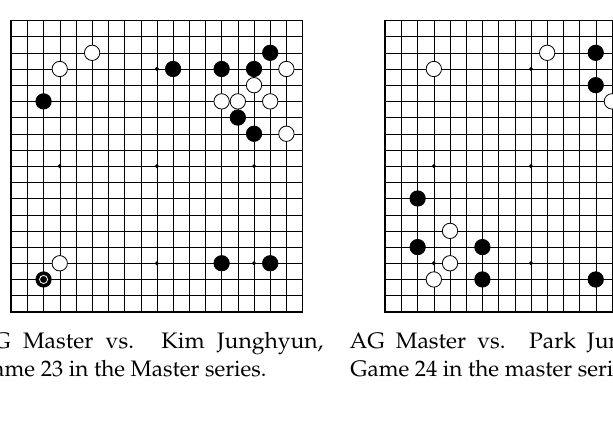
Figure 3. Shoulder hit on the 5th line goes against the previous wisdom of the balance of the 3rd (secures territory) and 4th line (creates influence). Early 3-3 invasion was considered to be a weak move, until strong AIs started to play it earlier and earlier (now as early as the 2nd move). Crawling on the second line again contradicts the idea of 3rd–4th line balance, but in this example it worked very